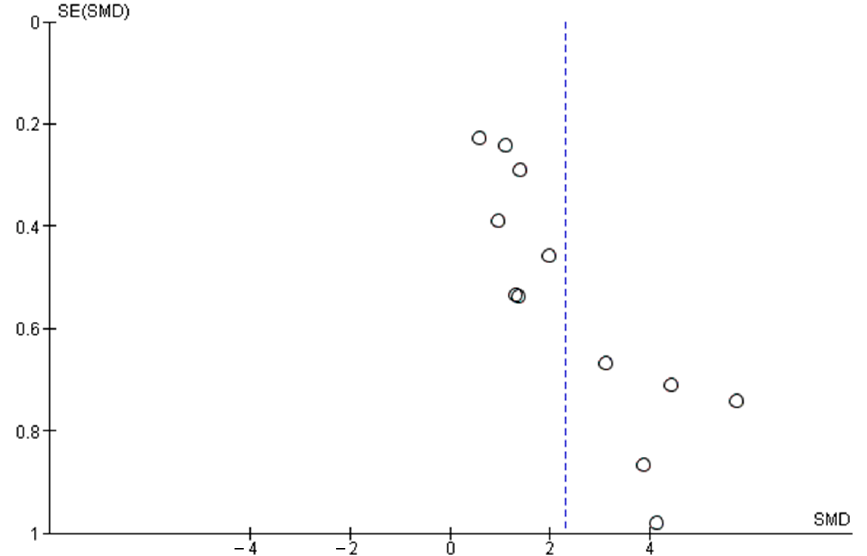
Figure 7. Funnel plot showing symmetrical distribution of studies indicating absence of publication bias in studies measuring the anthocyanin content in plants treated with the biostimulants. The figure was generated by Review Manager Software, ver. 5.4.1.